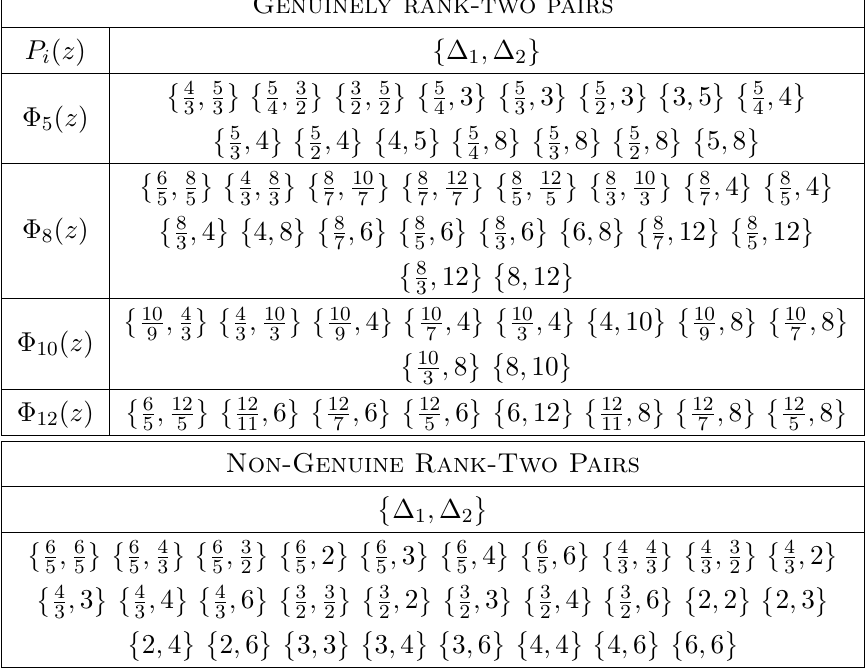
( z ) denotes a degree- d cyclotomic d